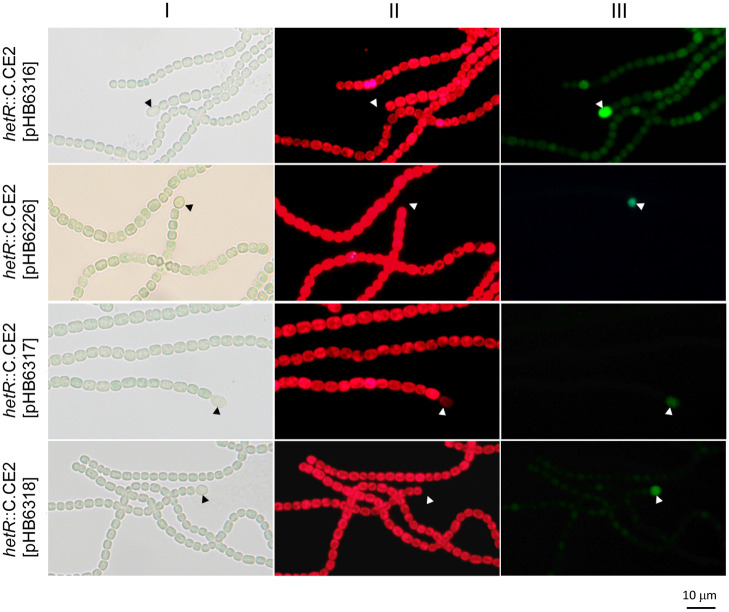
Light (I), autofluorescence (II) and GFP fluorescence (III) photomicrographs of Anabaena 7120 hetR::C.CE2 harboring plasmids with PntcA-hetP-hetZ and Ω-promoter-gfp.On pHB6316, pHB6226, pHB6317 and pHB6318, gfp was expressed from PhetR, PpatS, PhepB and PhglD, respectively. Photomicrographs were taken at 24 h after nitrogen stepdown. Solid arrowheads point to heterocysts.